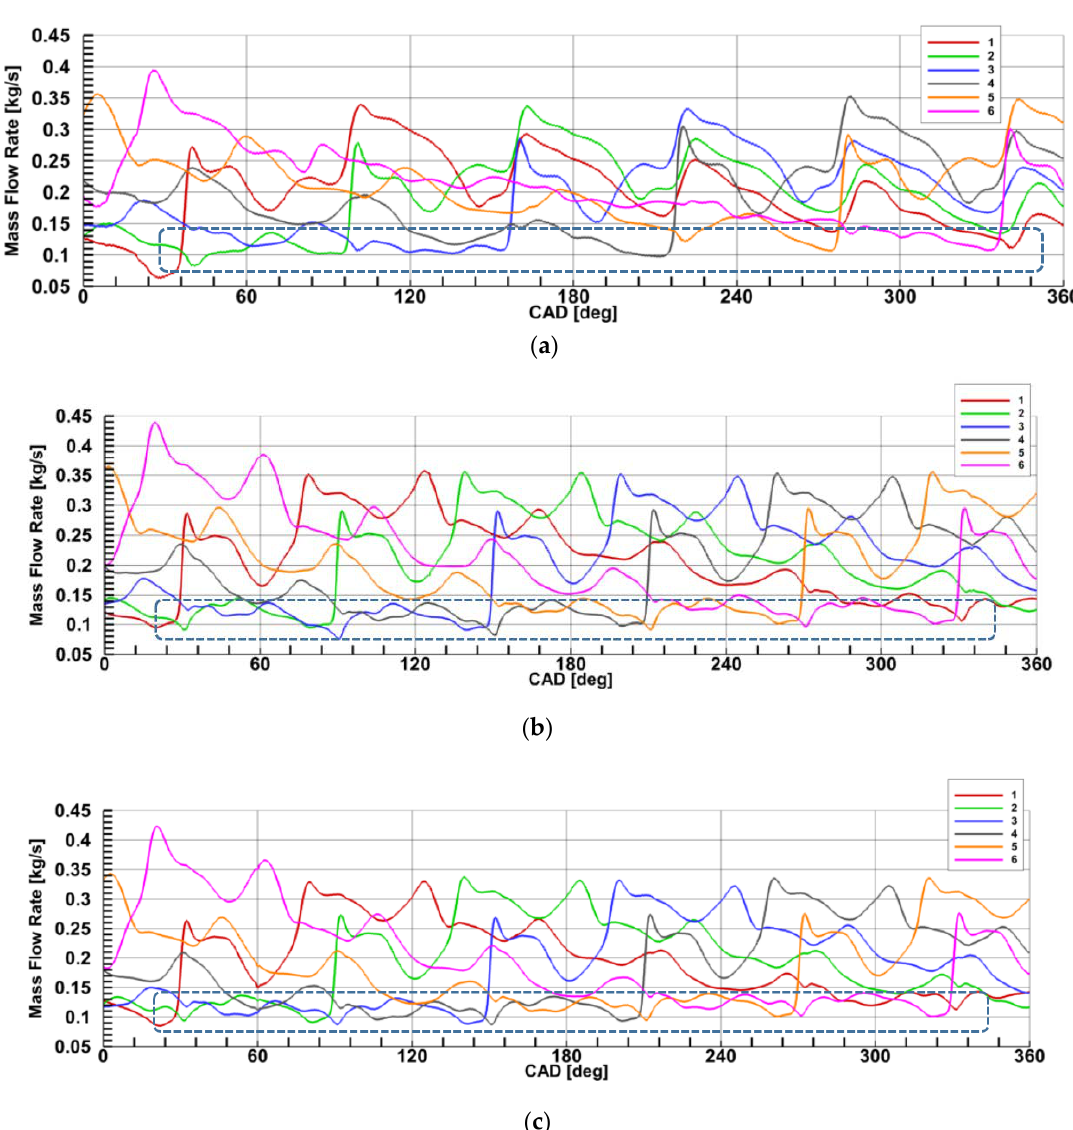
Figure 9. The area-average mass flow rate monitored at the Section 1-1 for: ( a ) n = 40,000 rpm; ( b ) n = 50,000 rpm; ( c ) n = 60,000 rpm.